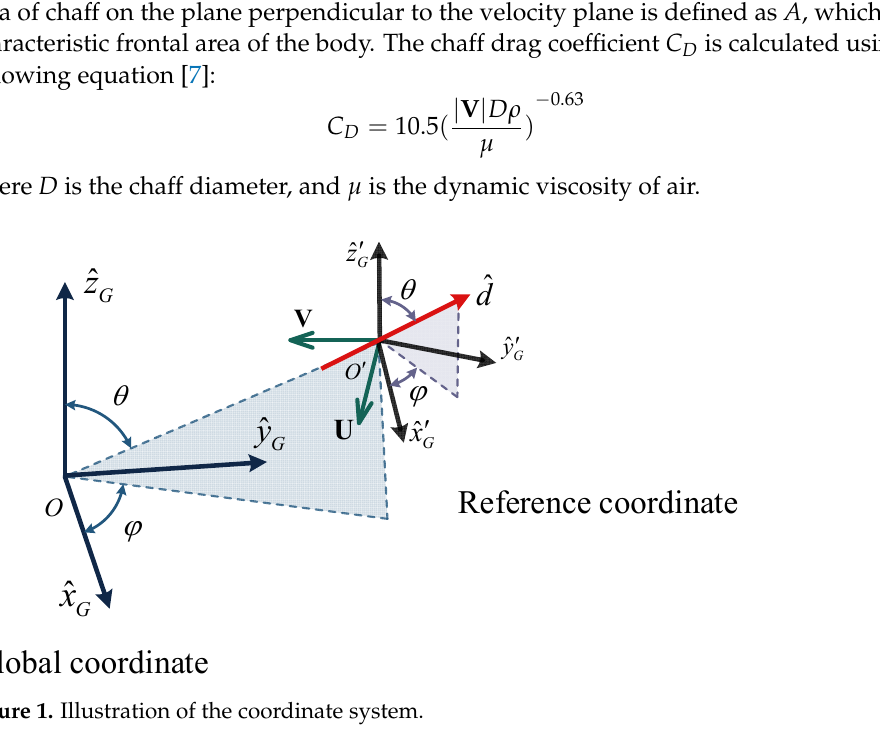
Figure 1. Illustration of the coordinate system.